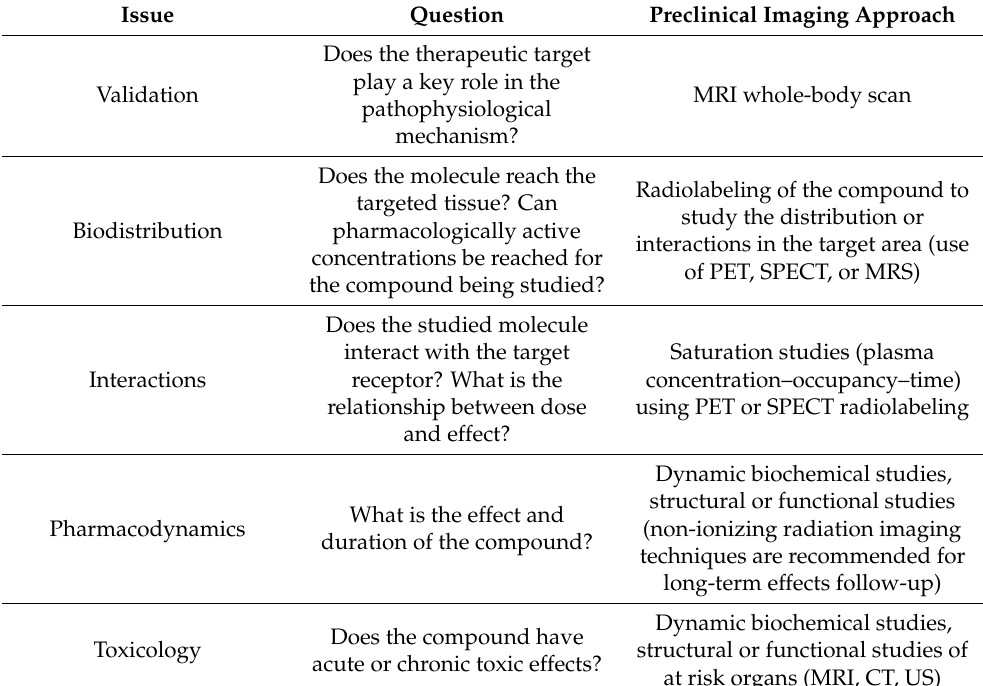
Table 3. Approaches to key questions on drug development using appropriate preclinical imaging methods for translational research (adapted after